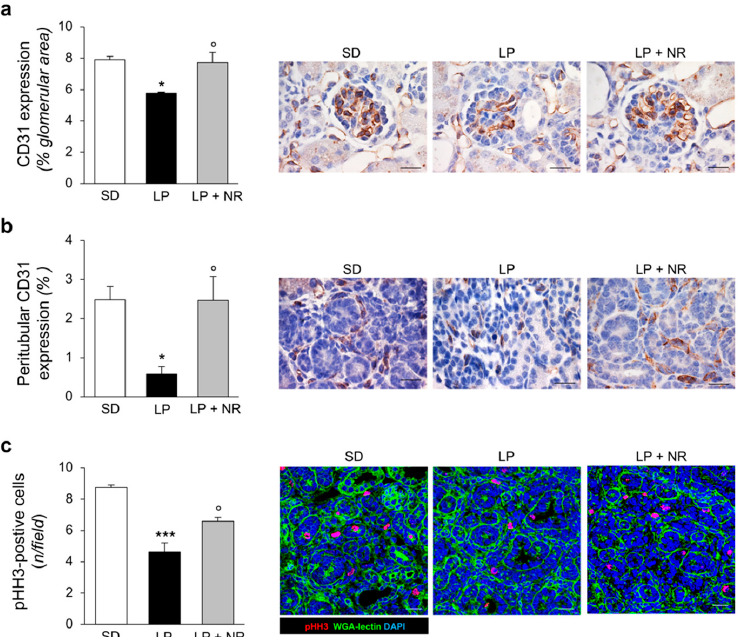
Figure 3. NR supplementation protects renal vasculature and increases cell proliferation in maternal LP diet offspring. ( a ) Quantification and representative images of the endothelial marker CD31 in glomeruli of SD, LP or LP + NR offspring ( n = 3 kidneys from 3 newborn mice per group). Scale bars, 20 µ m. ( b ) Quantification and representative images of the peritubular area positive for CD31 in SD, LP or LP + NR offspring ( n = 3 kidneys from 3 newborn mice per group). Scale bars, 20 μ m. ( c ) Representative images and quantification of cell proliferation assessed by pHH3 staining in kidneys from day 1 mice born to mothers fed a SD or LP supplemented or not with NR ( n = 3 kidneys from 3 newborn mice per group). Scale bars, 20 µ m. Results are presented as mean ± SEM and were analyzed with ANOVA with Tukey’s post hoc test. * p < 0.05, *** p < 0.001 vs. SD; ◦ p < 0.05 vs.